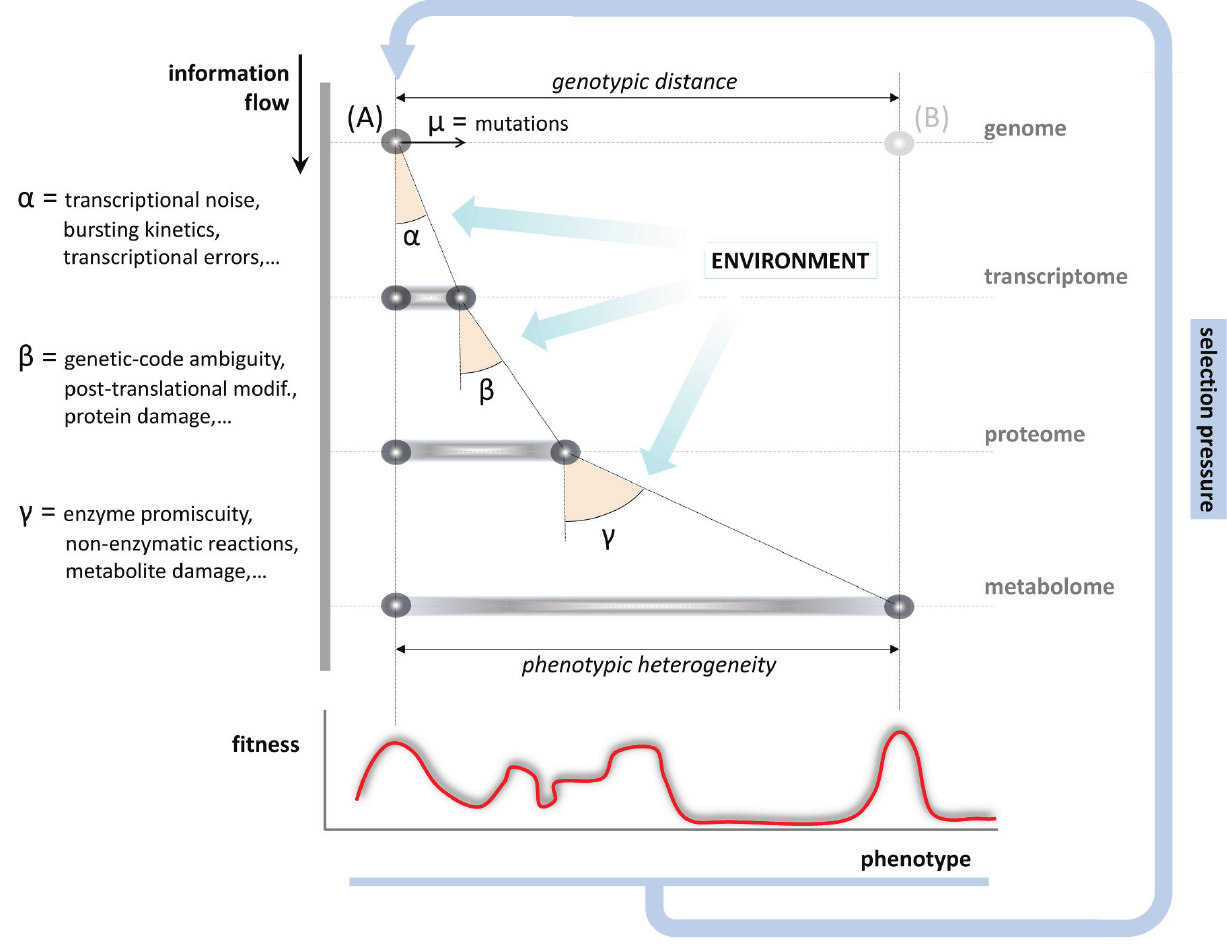
Figure 4. Impact of metabolic inaccuracy on the genotype-to-phenotype relationship. Biological processes, including transcription, translation and metabolism are not totally accurate. During the gene-protein-metabolite information flow, errors generated at each operational layer that are not compensated (depicted as angles (cid:3), (cid:4), (cid:5)) propagate, overall shaping the phenotypic space to be achieved from the same genotype (variation in the x-axis). Phenotypic variability arising due to error propagation can be enhanced by environmental stress conditions and enables a wide space of positions in the fitness landscape (red curve), all of which contribute to define the selection pressure over the given genotype ( A ). Promiscuity, noise, and unspecificity may thus facilitate the physiological adaptation to changing conditions, which would otherwise require the evolution to a different genotype ( B